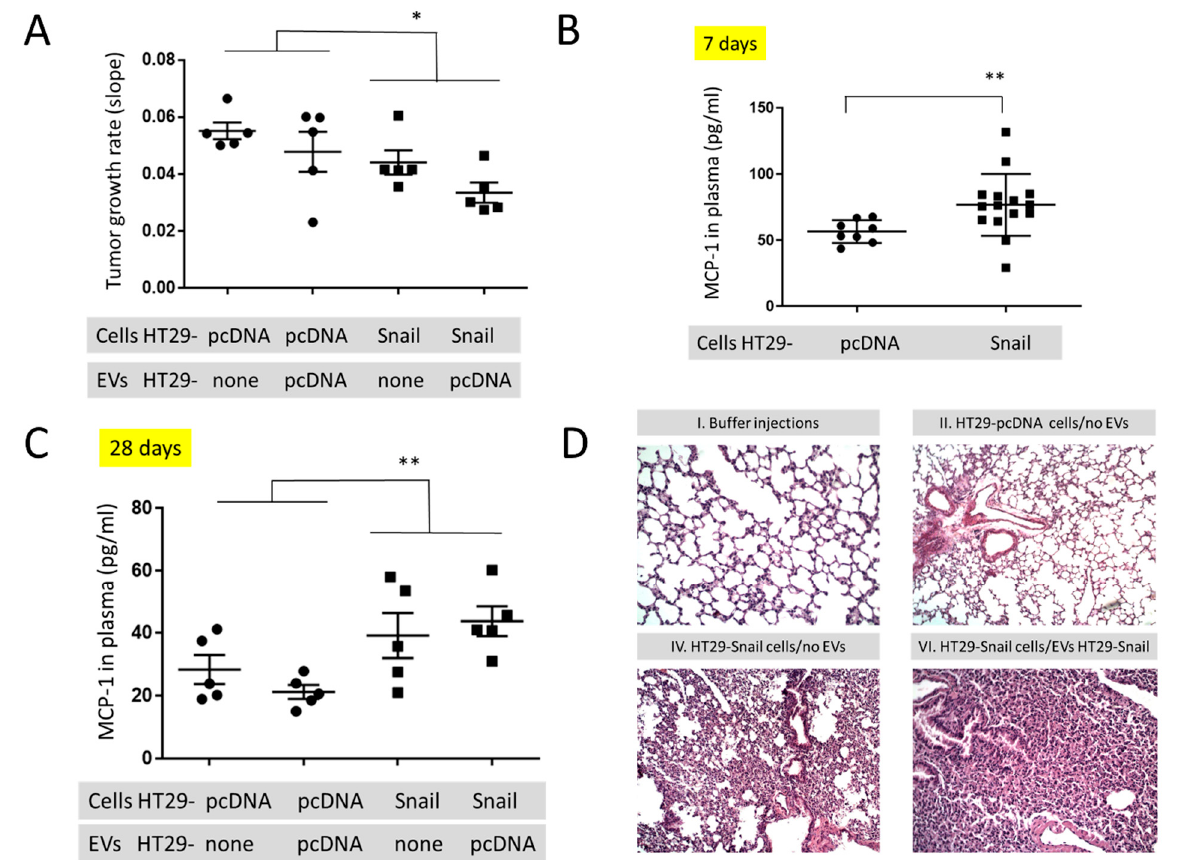
Figure 3. In vivo mouse studies in animals injected s.c. with HT29-pcDNA- (small dot) or HT29-Snail17- (small cube) cells. ( A ) The growth rate of tumours (day 12–28) in animals with HT29-pcDNA or HT29-Snail administered s.c. and additionally injected i.v. with EVs released by HT29-pcDNA, mean value ± SEM: 0.052 ± 0.04 and 0.039 ± 0.03, respectively ( B ) Levels of monocyte chemoattractant protein-1 (MCP-1/CCL2) measured in the plasma of mice at day 7 (before first injection of EVs). ( C ) Levels of monocyte chemoattractant protein-1 (MCP-1/CCL2) measured in the plasma of mice at day 28 (end of experiment). Mean value ± SEM for animals injected s.c. with HT29-pcDNA and HT29-Snail were 24.8 ± 2.7 and 41.5 ± 4.1, respectively. ( D ) Representative H&E staining of murine lungs. 100× magnification. The images of groups IV and VI (see Table 1) show interstitial pneumonia pictures. n = 10–15, * p < 0.02; ** p < 0.01. Table 1. Incidence of lung infection in mice with tumours inflicted by injection of control HT29- pcDNA or HT29-Snail cells followed by injections of various EVs.